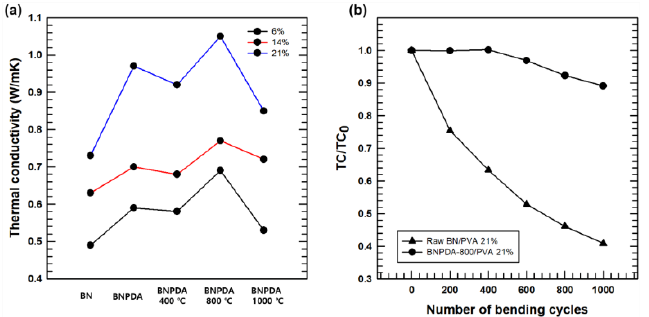
Figure 7. ( a ) Thermal conductivity of PVA composite films with raw BN and BNPDA. ( b ) The ratio of thermal conductivity before and after flexibility test.